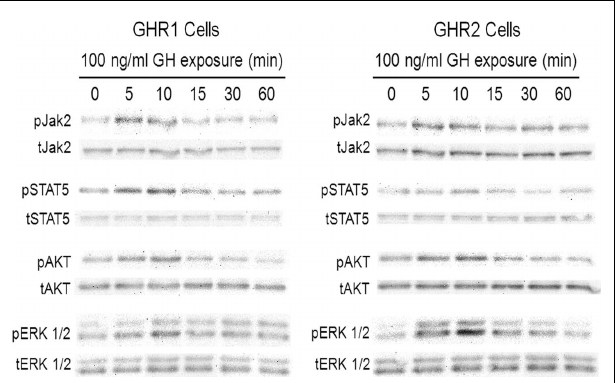
Table 1 | Specific binding of [ 125 I]-salmonid growth hormone to microsomes isolated from Chinese hamster ovary-K1 cells individually transfected with vector only or with vector containing cDNA that encodes rainbow trout growth hormone receptor 1 (GHR1) or growth hormone receptor 2 (GHR2). Vector only GHR1 GHR2 137 ± 31 a 1266 ± 42 b 1374 ± 53 b Units of specific activity are counts per minute; data are expressed as means ± SEM for triplicate determinations from three independent experiments. Groups with different letter are significantly different from each other (P < 0.050).